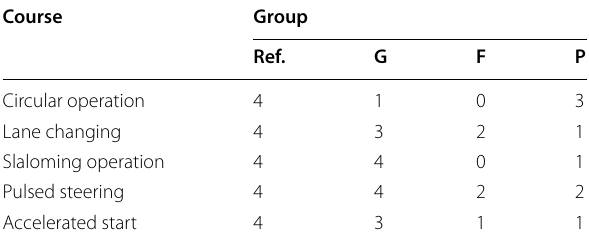
Table 1 Number of successful platooning vehicles on experiment for deciding